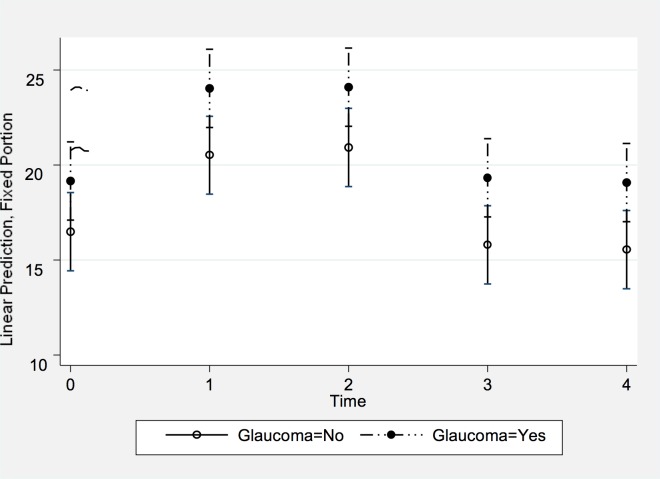
Least squares means and mean values of the covariates of the changes in IOP in the Halasana position over time.The X axis represents each time point an IOP measurement was taken (0 = Baseline seated; 1 = Immediate position; 2 = 2 minutes position; 3 = Post position seated; and 4 = 10 minutes post position seated). The Y axis represents the IOP in mmHg after adjusting for the covariates. Subjects with glaucoma diagnosis are depicted ‘Glaucoma = 1’; controls are ‘Glaucoma = 0’.